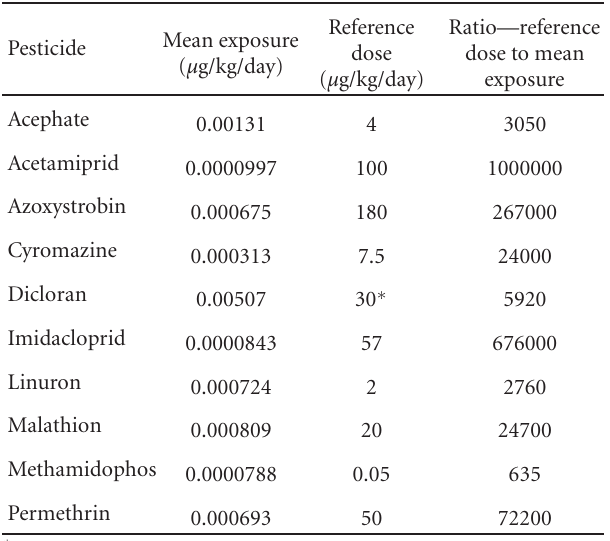
Table 7: Exposure estimates of the ten most frequently detected pesticides on grapes (imported).